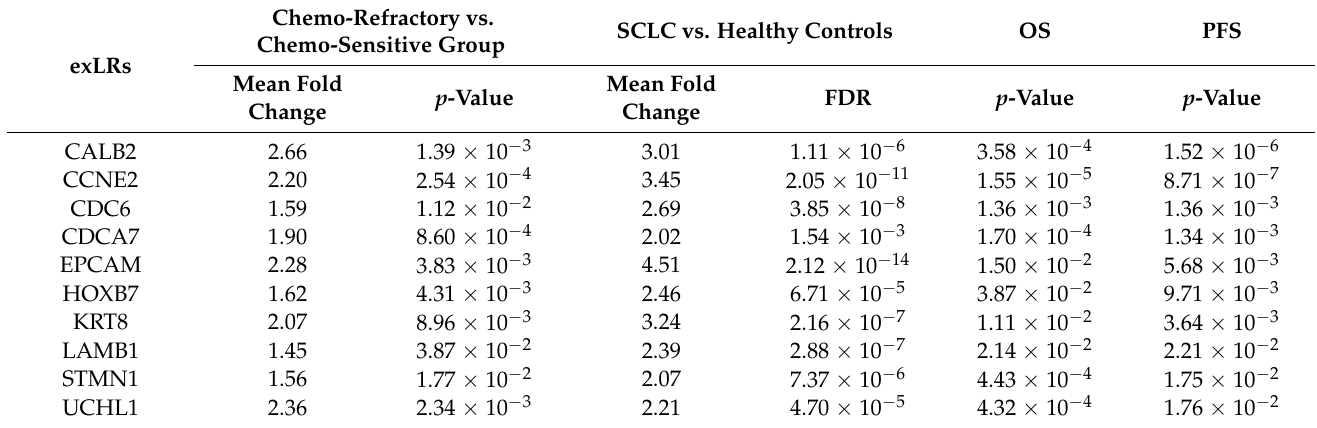
Table 3. Characteristics of differential expressions of the 10 exLRs identified in this study. SCLC vs. Healthy